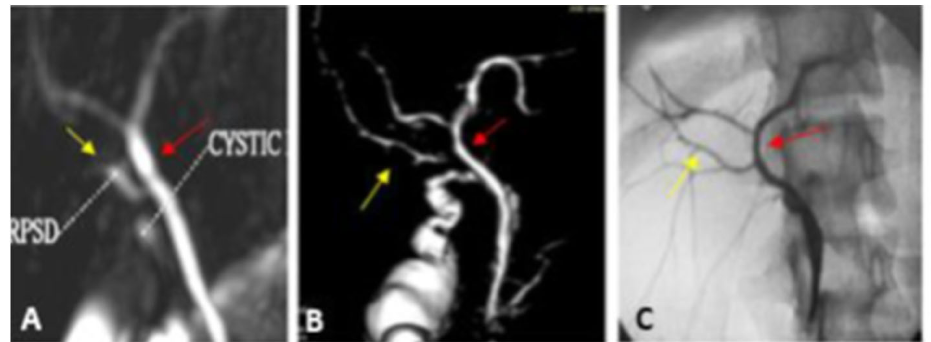
Figure 3. Type III ‐ a variant intrahepatic biliary anatomy. ( A ) Coronal oblique thin slap heavy T2 FAT SAT FSE image shows RPSD (yellow arrow) draining into the LHD (red arrow). ( B ) Antero ‐ posterior view of the post ‐ processed 3D VR coronal image reveals insertion of the RPSD into the LHD. ( C ) IOC AP view image confirms the MRCP findings. They show insertion of the RPSD (yellow arrow) into the distal part of the left hepatic duct (red arrow).